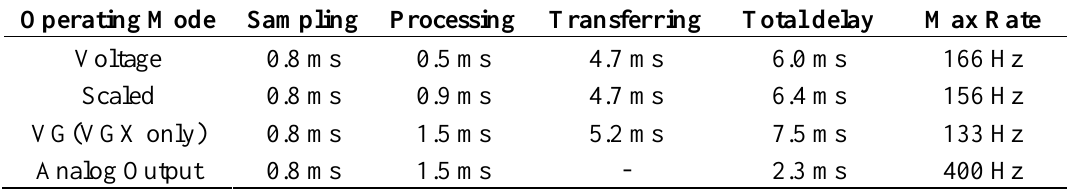
Table 1. IMU300 Series, IMU400 Series and VG300CB Timing (Data from